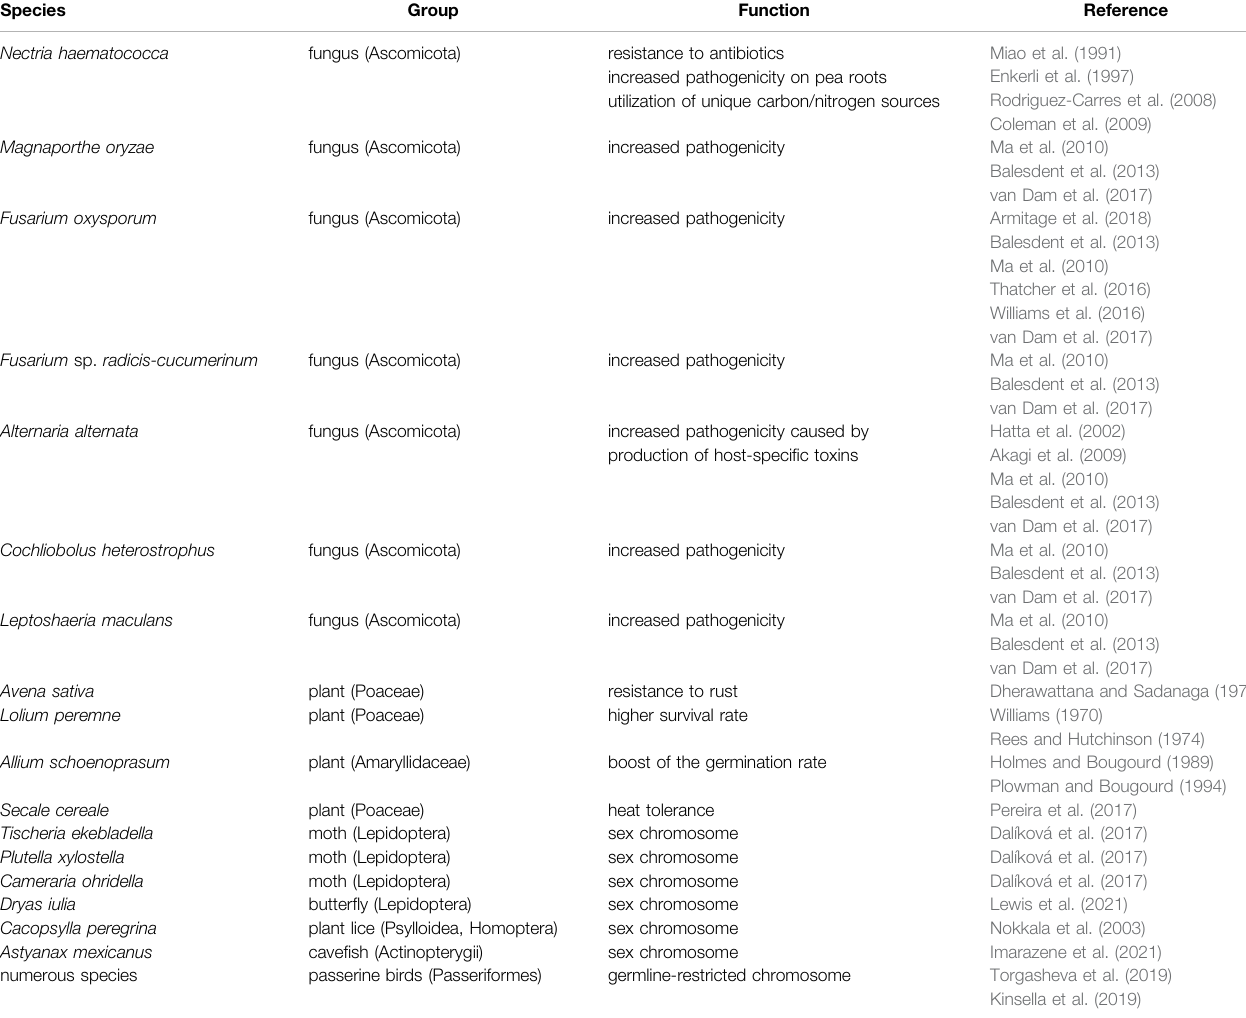
TABLE 1 | List of examples where B chromosomes have a bene fi cial or necessary function for their hosts.